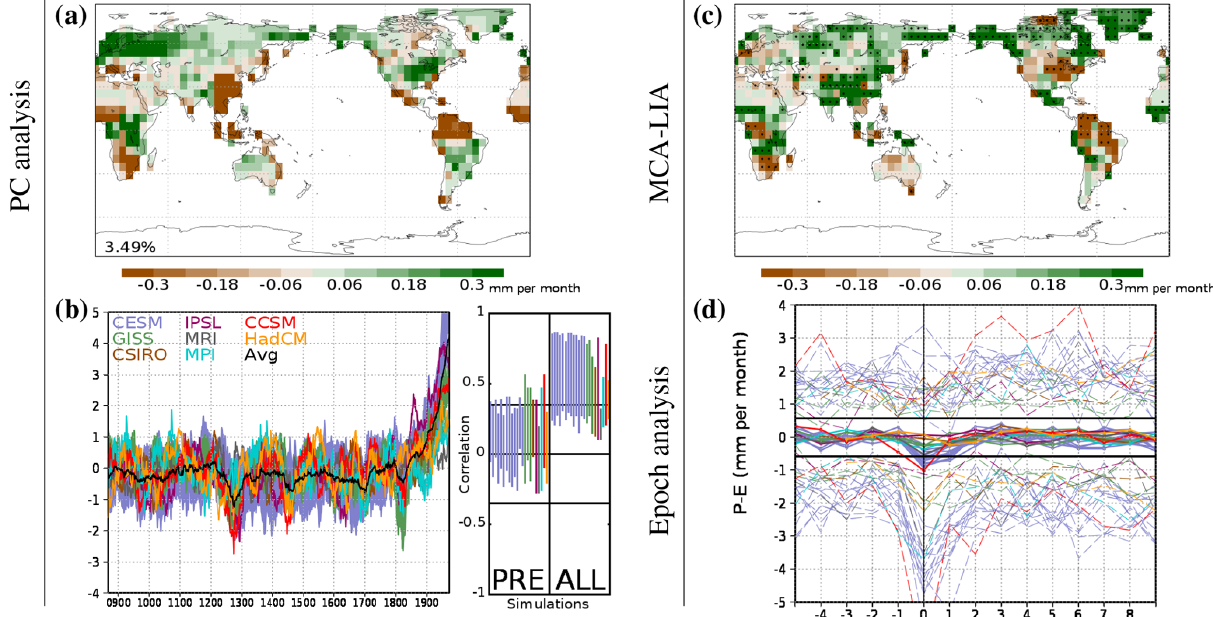
Figure 15. Analysis of P – E for the ensemble of simulations included in Table 1. (a) Second EOF and (b) second PC time series for each simulation, as well as the average PC of all the simulations (black line). The percentage of explained variance is shown within the EOF map. The range of correlations between the PC of each simulation and those of other simulations is also included on the right of the plotted PCs both for the whole period (ALL) and for the preindustrial era (PRE). For these correlations, the significance level ( p < 0 . 05) accounting for autocorrelation is shown with a black line. (c) Map of P – E differences between MCA and LIA. Dots indicate locations where the differences are significant ( p < 0 . 05). (d) Composite average (solid lines) and maximum and minimum (dashed lines) global P – E anomalies in the 5 years before and 10 years after the 12 main volcanic eruptions of the LM. The vertical line indicates the year of the volcanic event. The horizontal black lines show the significance level of the average ( p < 0 . 10) based on the distribution of averages of 12 years generated with 2200 sets randomly taken from the whole period excluding the years of the 12 main volcanic eruptions and the 10 years after